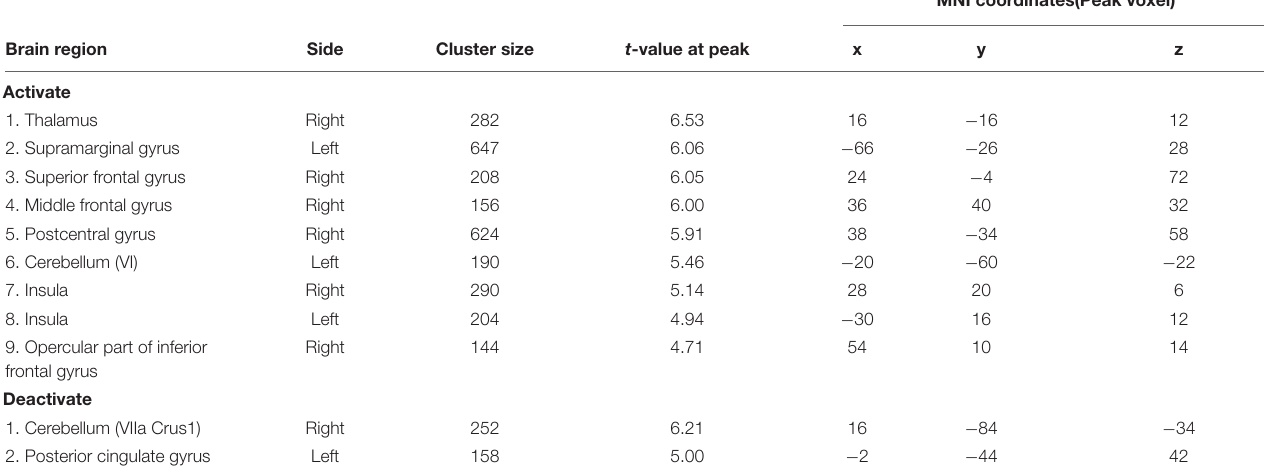
TABLE 1 | Summary of GLM